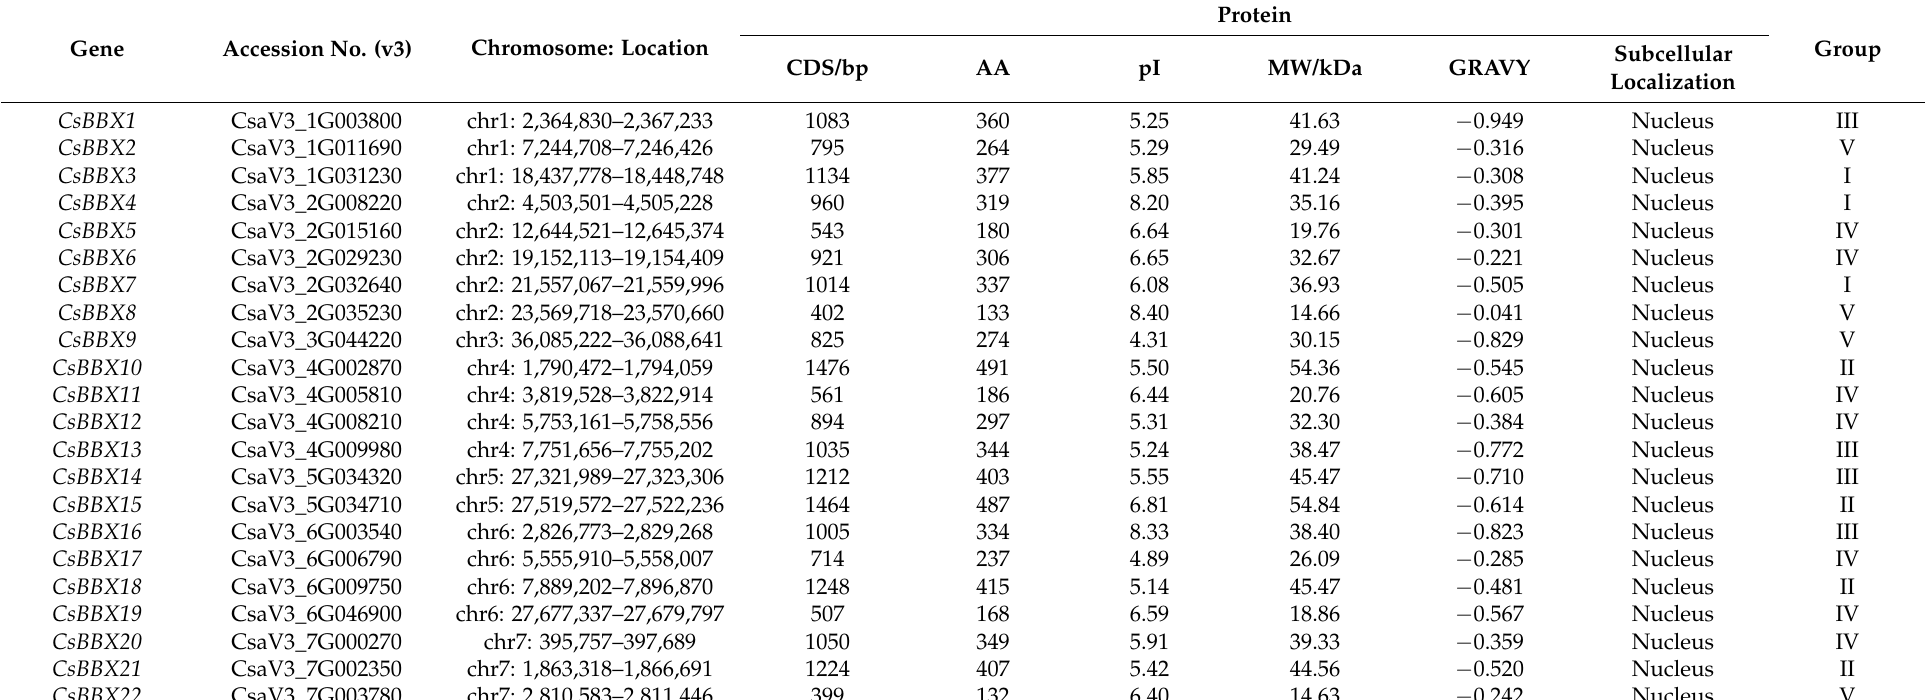
Table 1. Identification and characterization of BBX gene family in